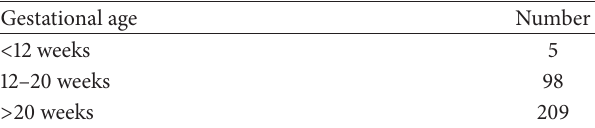
Table 1: Number of malformations at different gestational